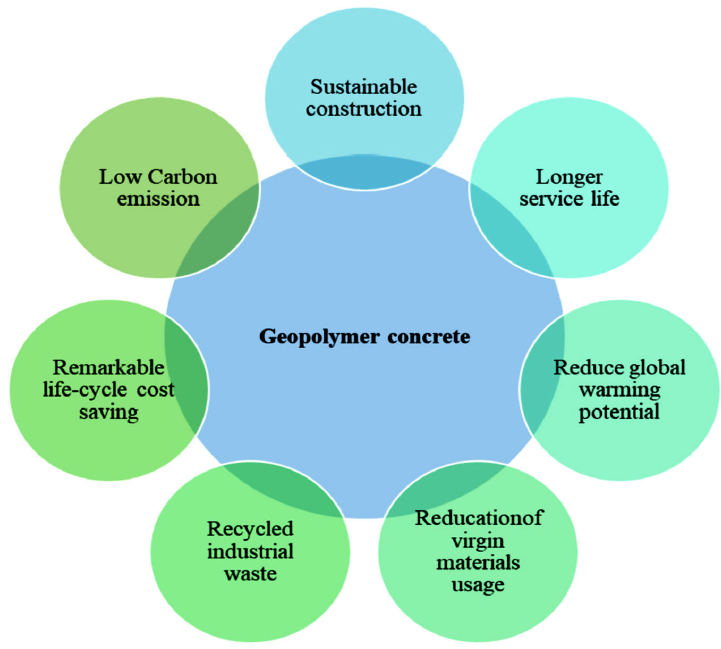
Figure 3. Benefits of GP concrete in sustainable construction. Adapted from [35].